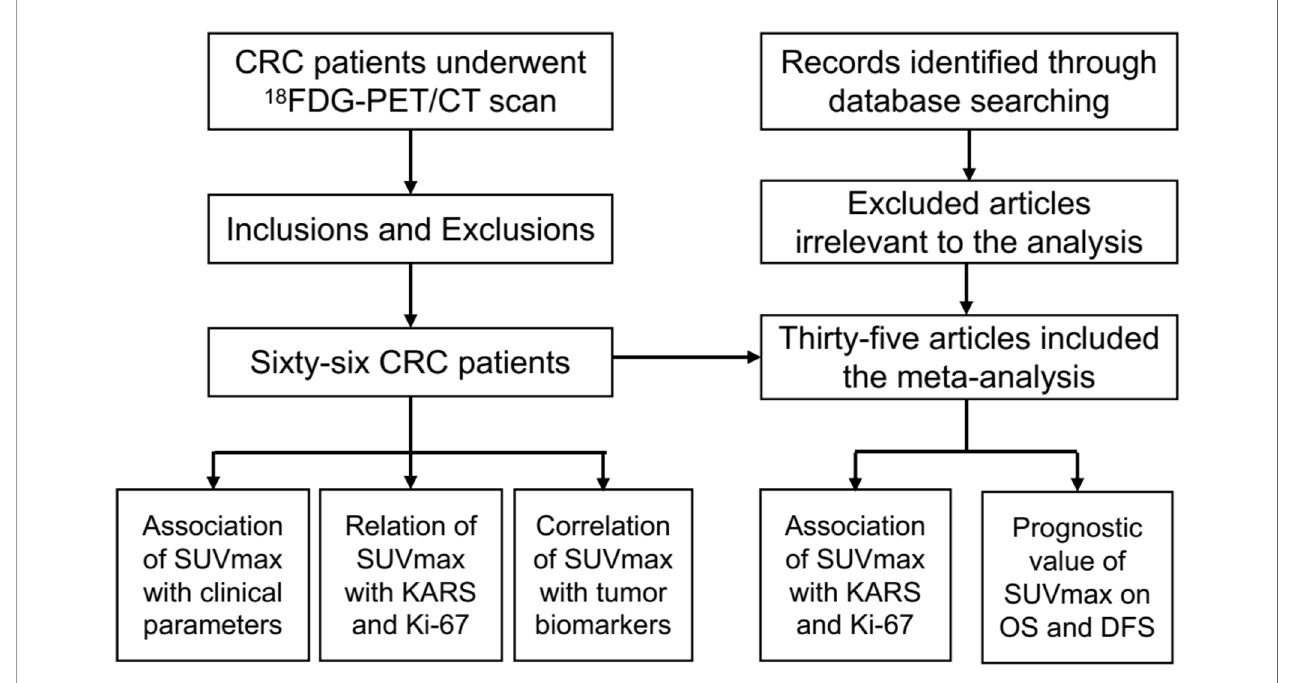
FIGURE 1 | The fl ow chart of the present